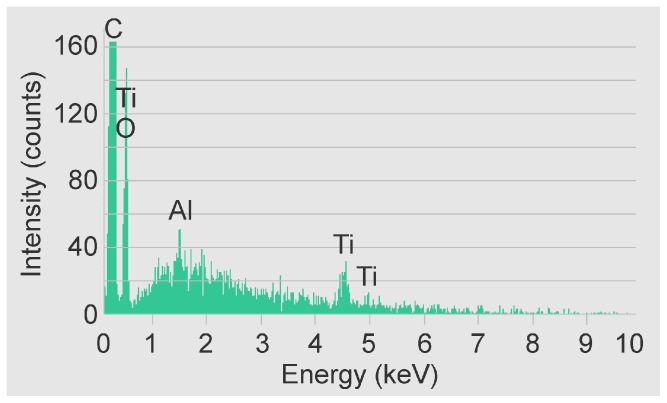
Energy Dispersive X-ray analysis.EDX confirms presence of titanium, oxygen and aluminum on the scratched-off nanotubes from surface of an anodized sample placed on carbon tape.